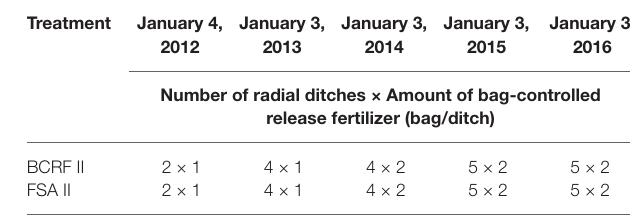
TABLE 1 | Fertilizing dates and